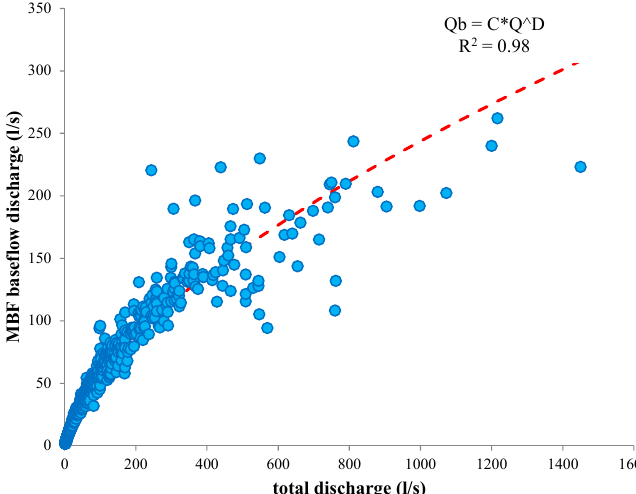
Figure 3. Relationship between total discharge and baseflow discharge derived by the application of the mass balance filtering (MBF) method at the daily scale, for the Ciciriello catchment.